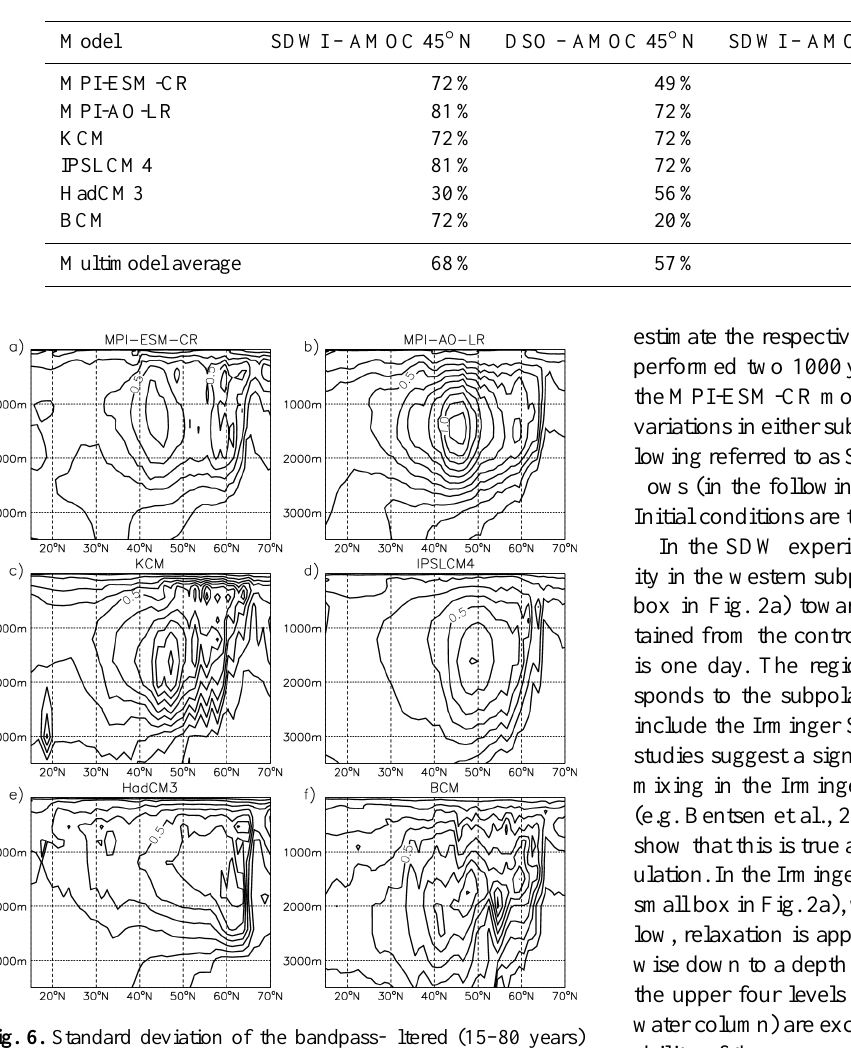
Table 3. Summary of the maximum variance of the bandpass-filtered (15–80 years) Atlantic meridional overturning streamfunction at 45 and 30 ◦ N explained SDWI and DSO in the different control simulations, deduced from Figs. 3 and 4 using (correlation coefficient) 2 .